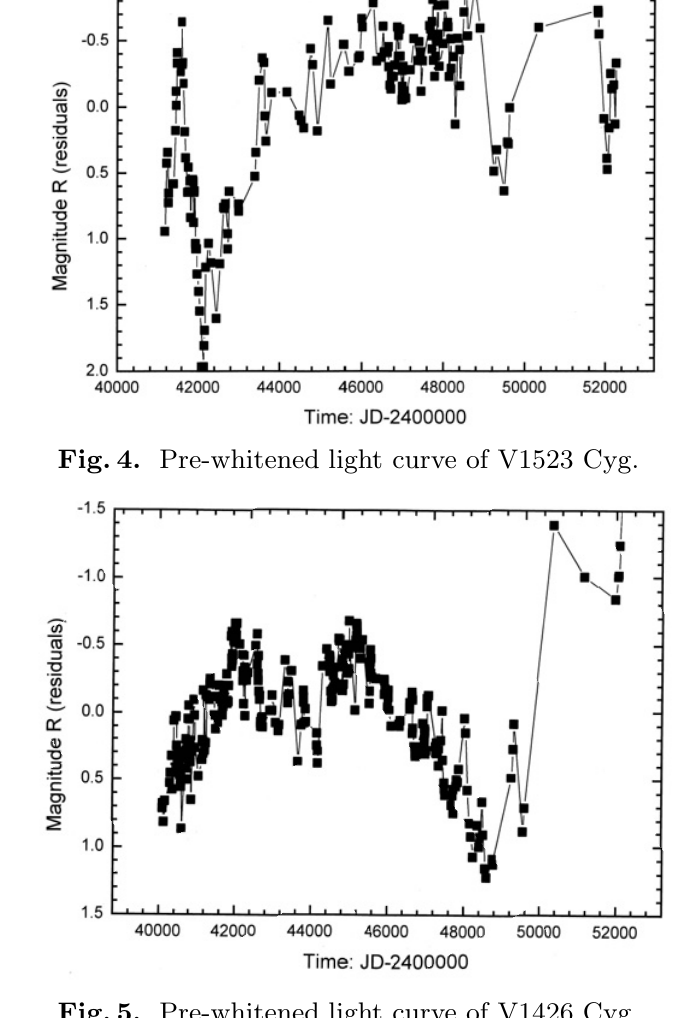
Fig. 5. Pre-whitened light curve of V1426